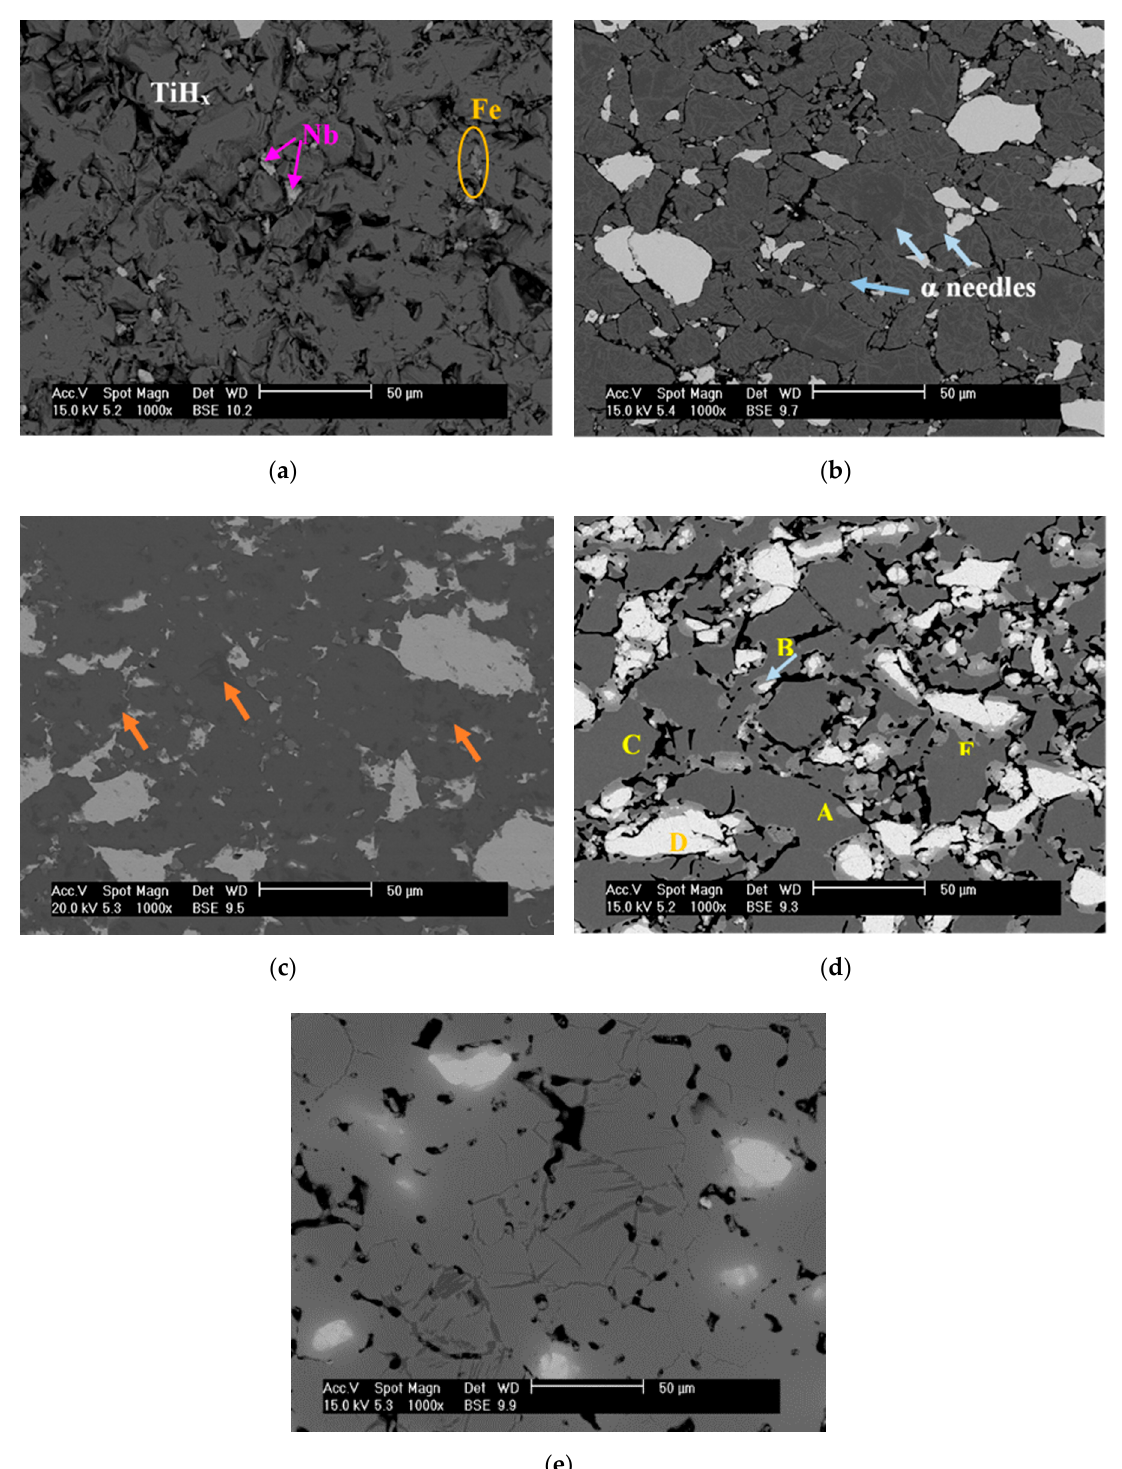
Figure 5. Scanning Electron Microscopy images in backscattered electrons mode (BSE-SEM) for TiH 2 -5Fe25Nb heated at di ff erent temperatures: ( a ) 400 ◦ C, ( b ) 500 ◦ C, ( c ) 650 ◦ C, ( d ) 800 ◦ C, and ( e ) 1100 ◦